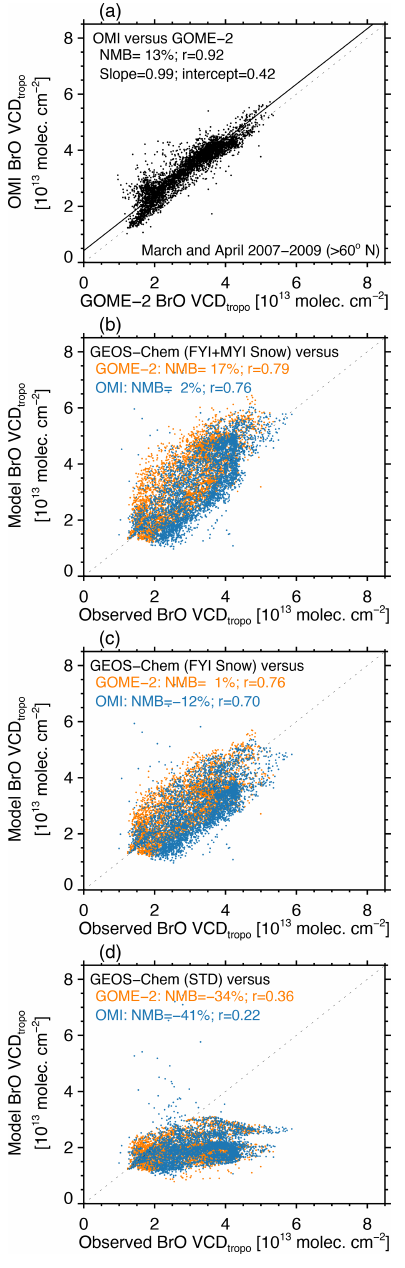
Figure 3. (a) Scatterplot of GOME-2 and OMI monthly mean VCD tropo for March and April 2007–2009 poleward of 60 ◦ N. (b) Scatterplot of VCD tropo calculated with the FYI+MYI Snow simulation and retrieved by GOME-2 (orange circles) and OMI (blue circles). (c) Same as panel (b) but for the FYI Snow simula- tion. (d) Same as panel (b) but for the STD simulation. The normal- ized mean bias (NMB; see definition in Sect. 3.1), Pearson correla- tion coefficient, and slope are shown in each panel. For panel (b) , the slope and intercept of the reduced-major-axis regression line (solid line) are also indicated. The dashed line corresponds to the 1:1